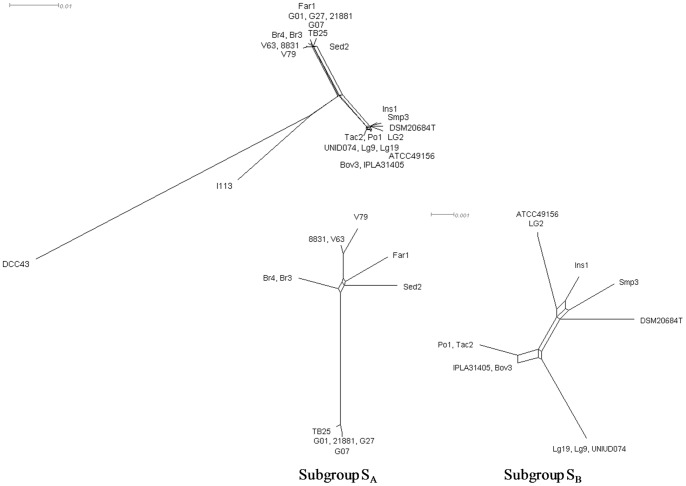
Splits decomposition analysis of L. garvieae population and subgroups.Parallelograms identify interconnected network of phylogenetic relationships between strains.